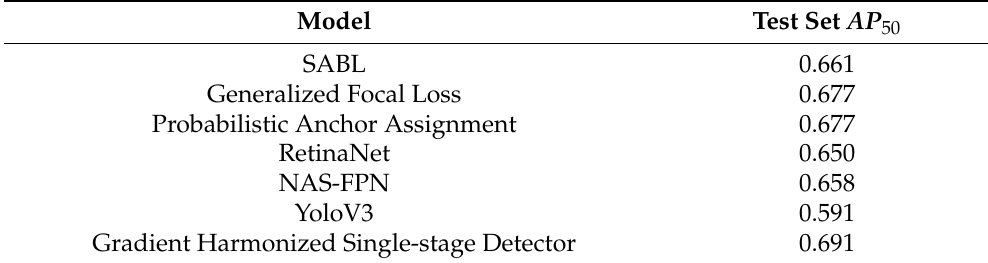
Table 3. Performance of the one-stage methods for the test set using AP 50